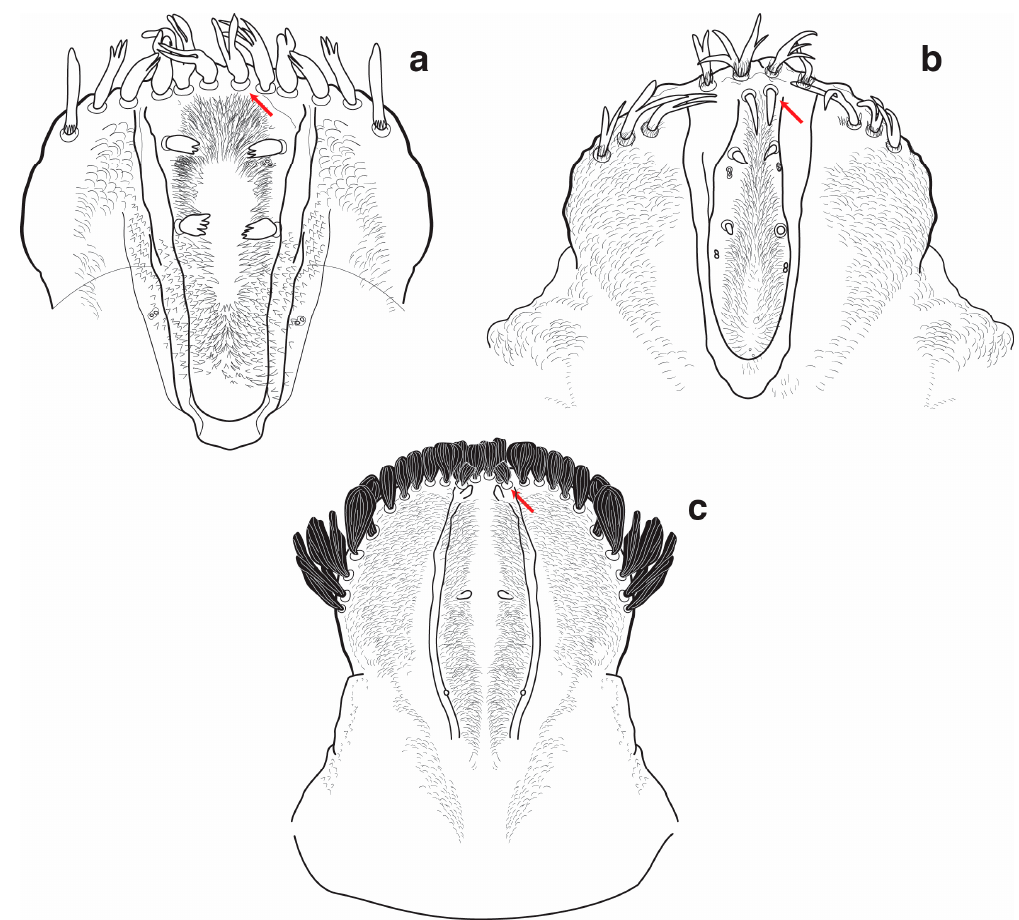
Figure 30. Epipharynx, larva: ( a ) Foveolus ; ( b ) Cosmopolites; and ( c ) Rhinostomus . 17. Minute setae apically on labrum/epipharynx (Figure 31)